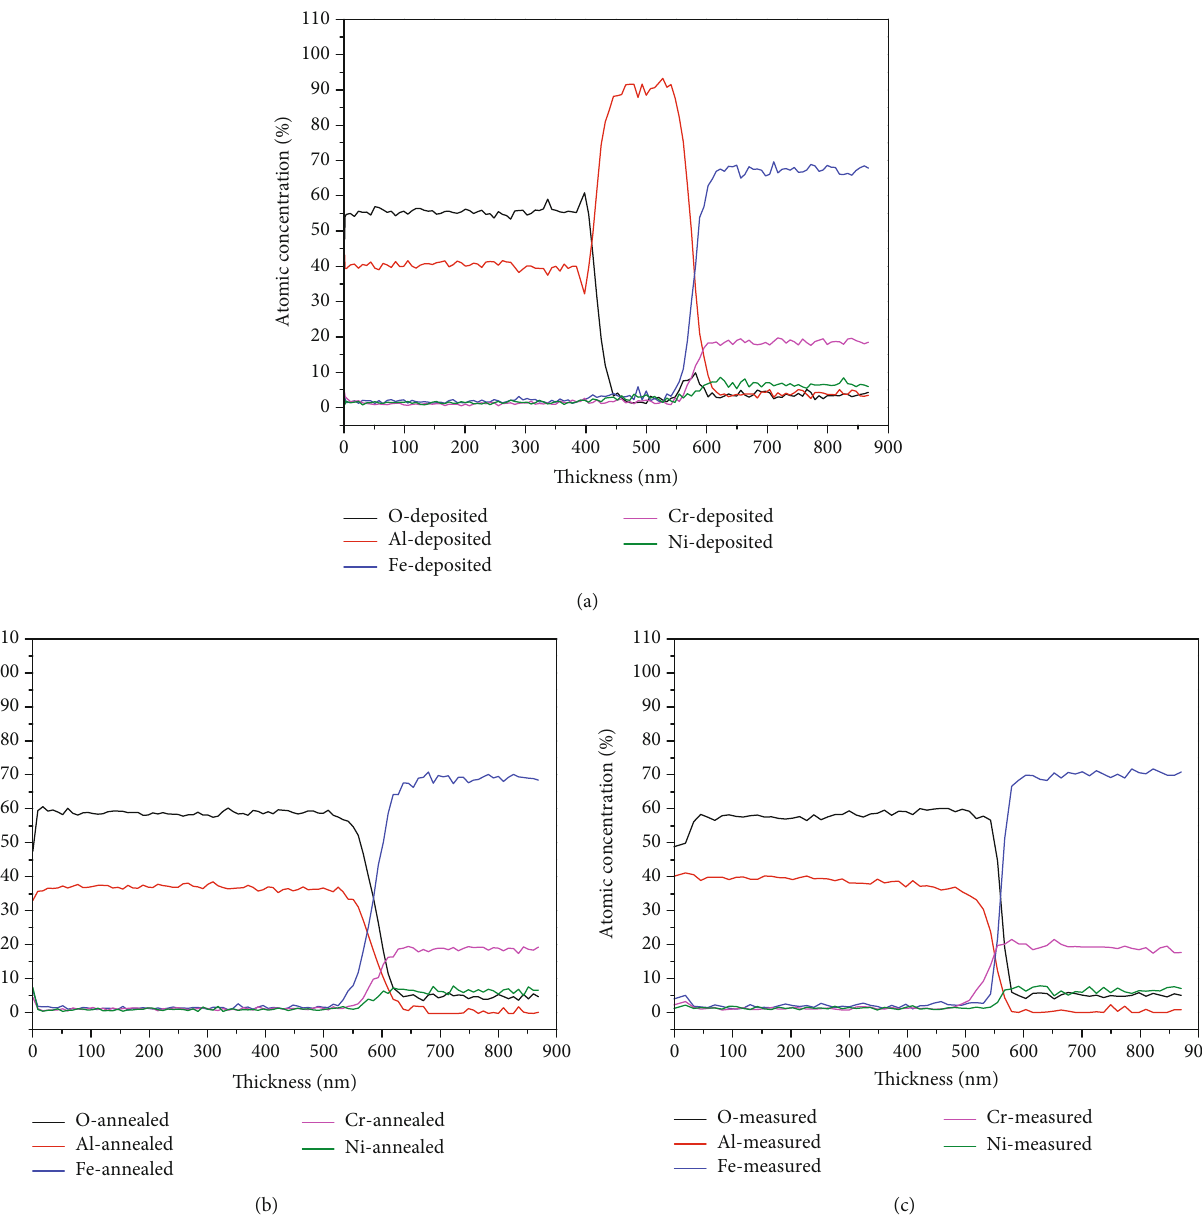
Figure 4: AES depth pro fi le of the Al/Al deuterium permeation